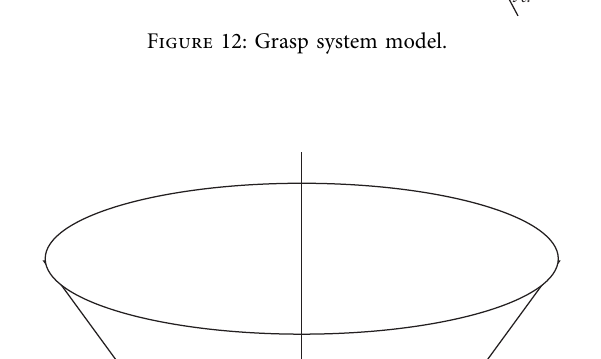
Figure 12: Grasp system model.